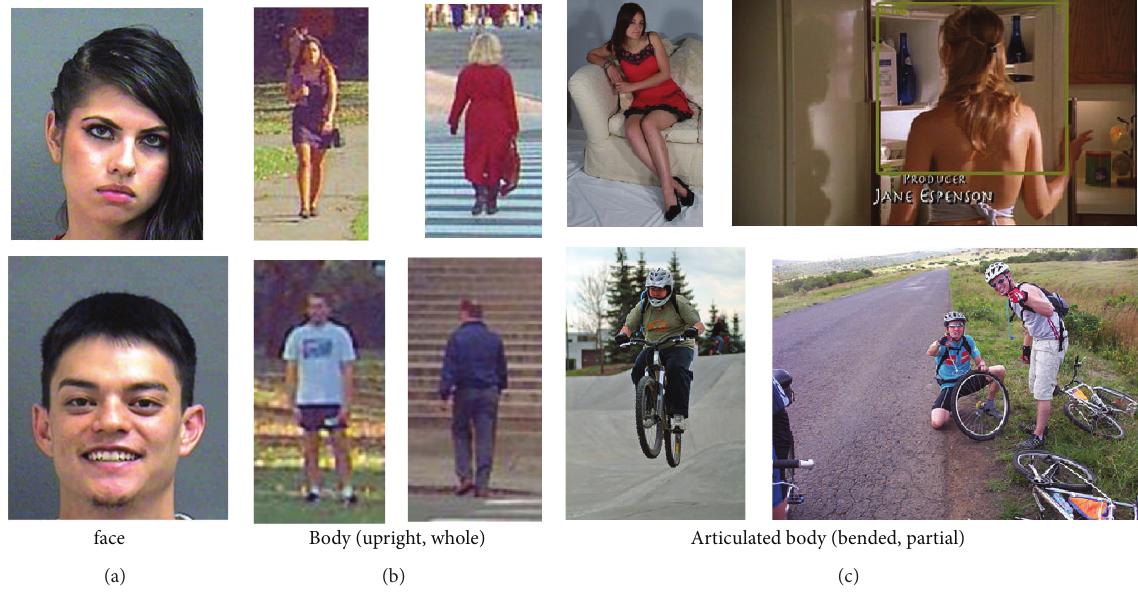
Figure 1: Gender recognition using different modalities. (a) Face images; (b) upright and whole body, for example, pedestrian, where the alignment problem is trivial; (c) articulated bodies which have various body part variations and even only partial body being